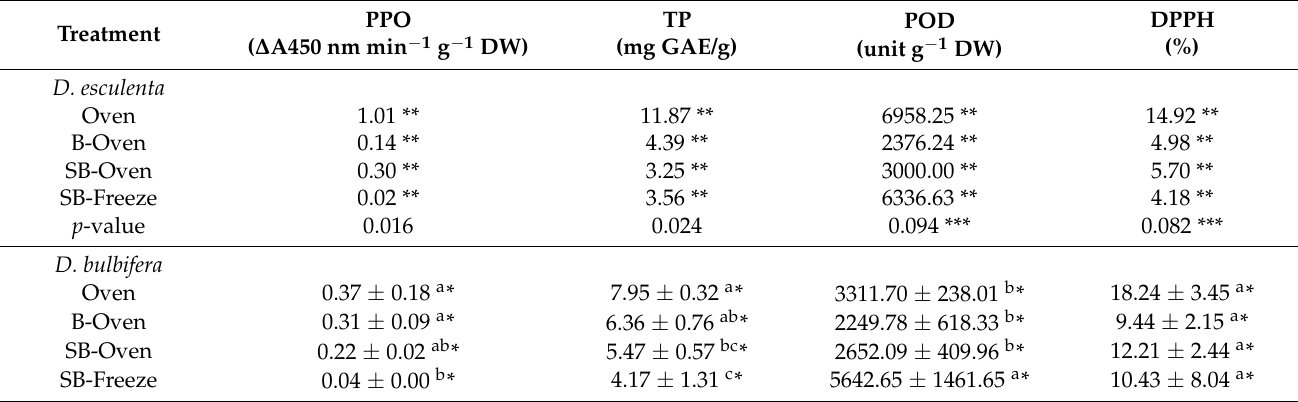
Table 4. Functional properties of yam flour prepared with different processing